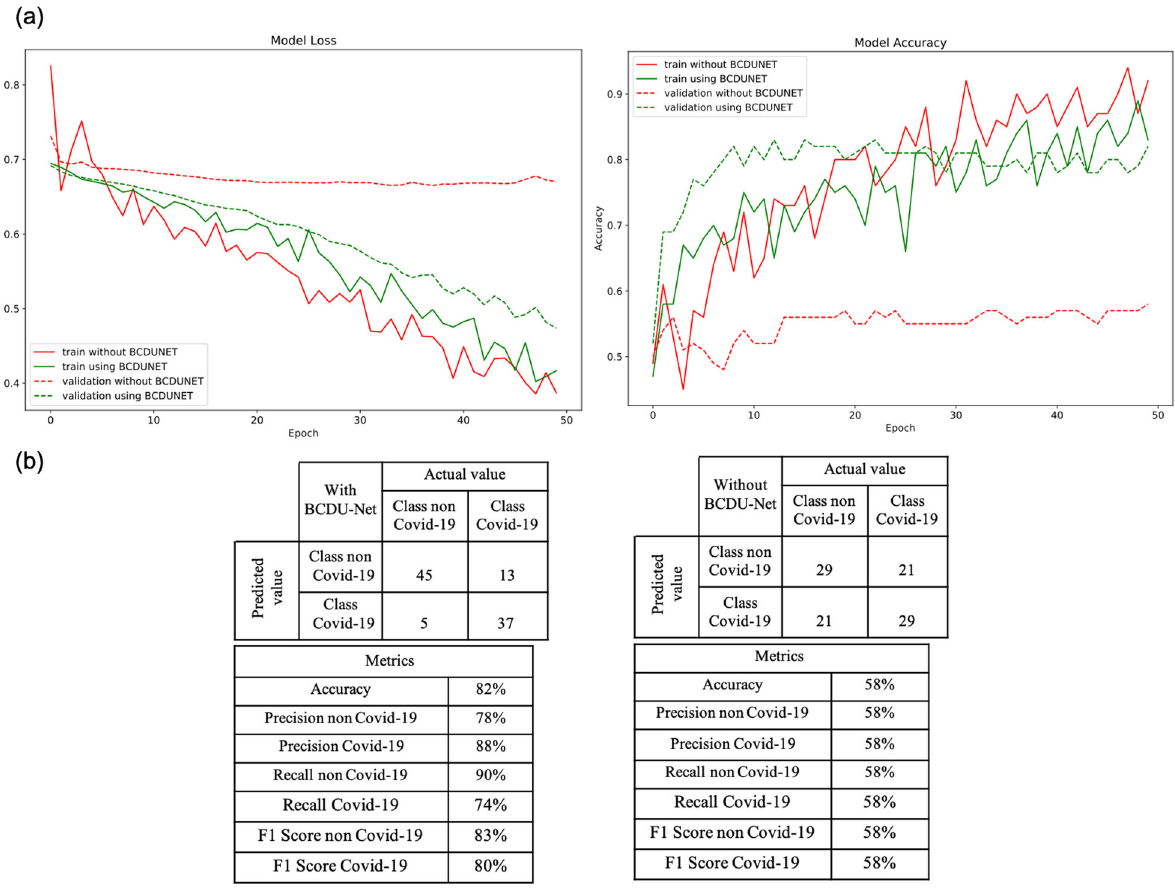
Fig. 1 BCDU-Net increases the robustness of the CNN model. a To show the effect of BCDU-Net on the preprocessing, the procedure was done with and without applying BCDU-Net/Perlin noise. The outcome of the model is presented with respect to loss and accuracy. b The confusion matrix and other classi fi cation related metrics in detail. The results shown in this fi gure are based on just 50 randomly selected cases for each class of Covid versus